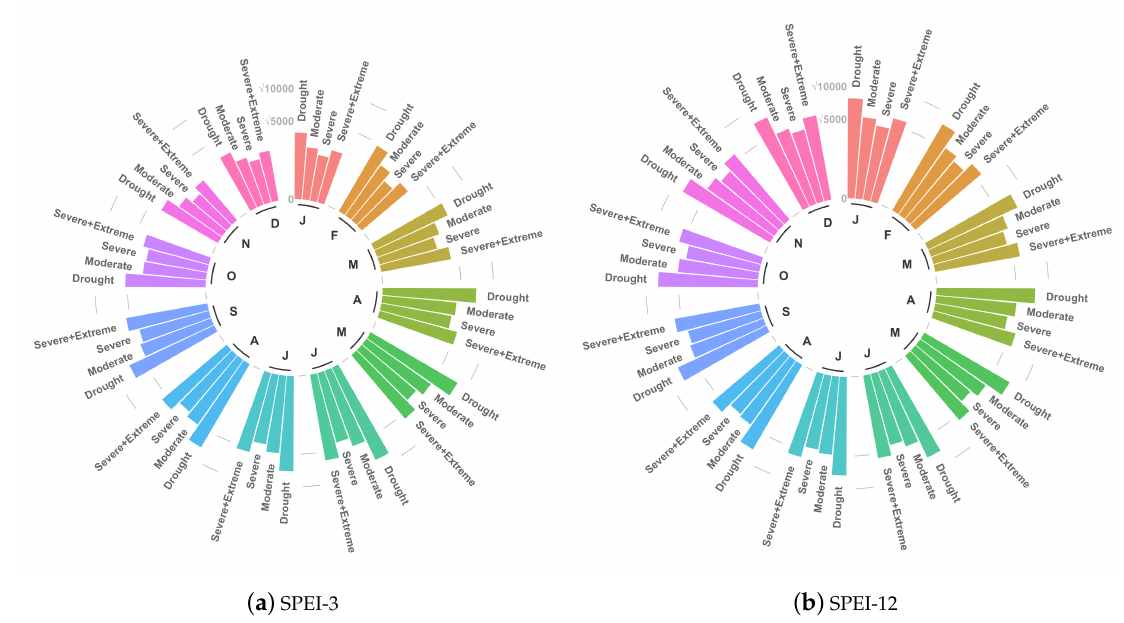
Figure 7. Circular plots of the frequency of SPEI drought events when the NHPP test results in a positive significant trend of droughts for each class and month given that M-K test also results in a positive significant trend in the period 1901-2018: ( a ) SPEI-3; and ( b ) SPEI-12. (The y-axis is drawn as square root of frequency to highlight the differences between